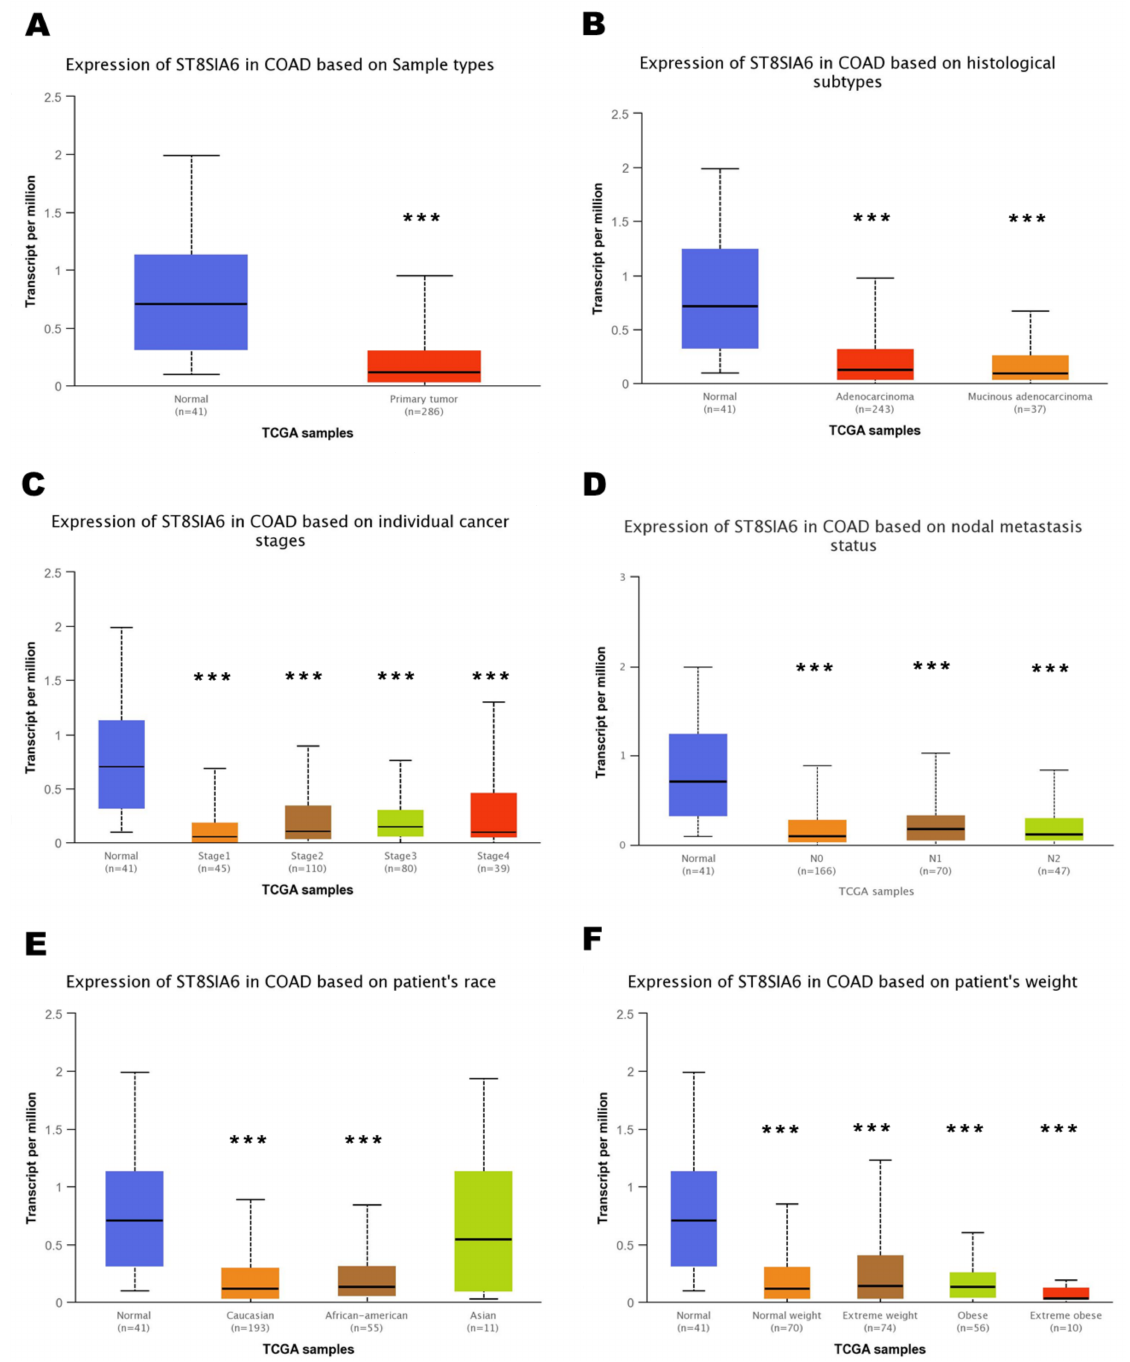
Figure 1. The mRNA expression of ST8SIA6 in colon cancer based on the TCGA database from UALCAN. ( A ) Boxplot showing relative expression of ST8SIA6 in normal individuals or colon adenocarcinoma (COAD) patients. ( B ) Boxplot showing relative expression of ST8SIA6 in normal individuals or COAD patients based on histological subtypes. ( C ) Boxplot showing relative expression of ST8SIA6 in normal individuals or COAD patients with 1, 2, 3, or 4 stages. ( D ) Boxplot showing relative expression of ST8SIA6 in normal individuals or COAD patients based on nodal metastasis status. ( E ) Boxplot showing relative expression of ST8SIA6 in normal individuals of any ethnic group or COAD patients of Caucasian, African-American, or Asian ethnic group. ( F ) Boxplot showing relative expression of ST8SIA6 in normal individuals or COAD patients with average weight, extreme weight, obesity, or extreme obesity. p -value Significant Codes: *** <0.001 compared with normal